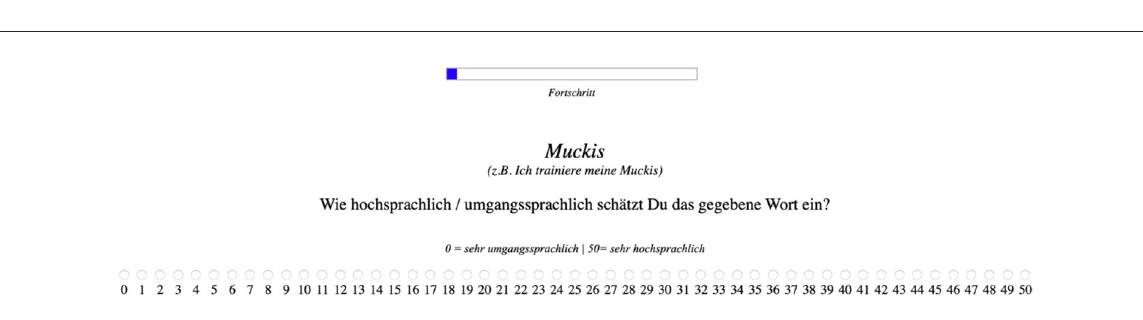
FIGURE9 Project C03: Formality rating of a target word in a sentence